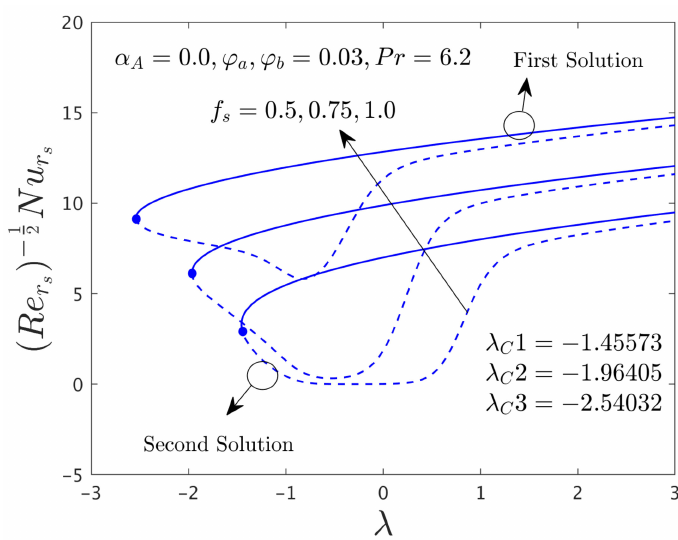
Nu r against λ for numerous choices of f s s s